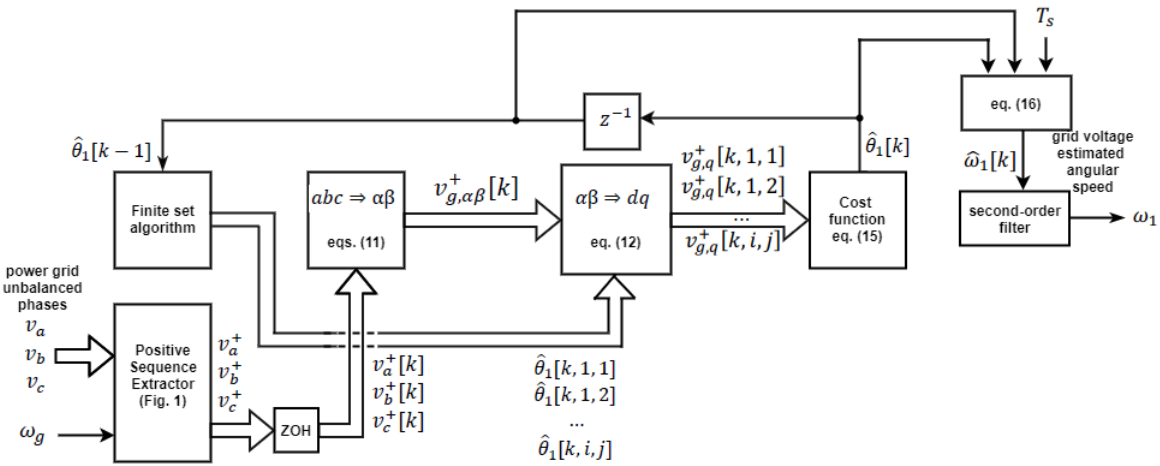
Figure 2. Block diagram of the proposed One-cycle Fourier-Finite Set-Phase-Locked Loop